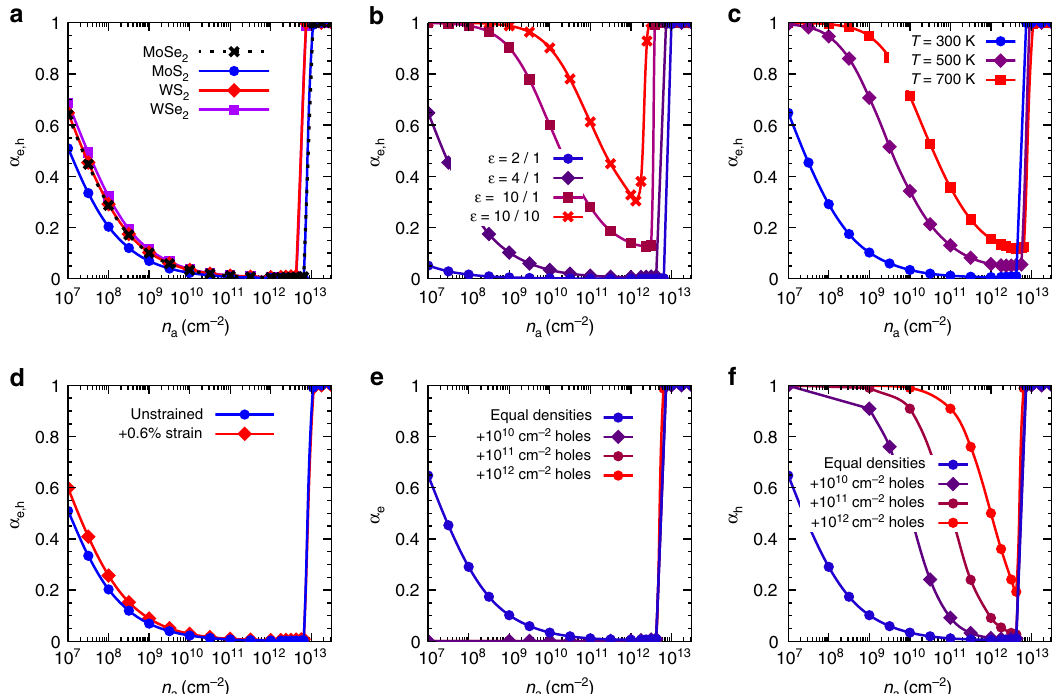
þ n Fig. 2 Degree of ionization as a function of excitation density. n a ¼ n a X denotes the total density of electrons or holes. In general, a fully ionized free plasma ( α a = 1) is found above the Mott density, excitons dominate ( α a (cid:3) 1) below the Mott density and ionization appears again at very low densities. If not stated otherwise, the temperature is 300 K. a Comparison of different TMDC materials on SiO 2 substrate. b Comparison of WS 2 in different dielectric environments with dielectric constant ε for the bottom/top surrounding of the monolayer. c Comparison of WS 2 on SiO 2 substrate for different temperatures. d In fl uence of strain for MoS 2 on SiO 2 substrate. The unstrained layer corresponds to a lattice constant a = 3.18 Å, while tensile biaxial strain is simulated by a = 3.20 Å. e Fraction of ionized electrons for different levels of hole doping of WS 2 on SiO 2 substrate. f Fraction of ionized holes for different levels of hole doping of WS 2 on SiO 2 substrate